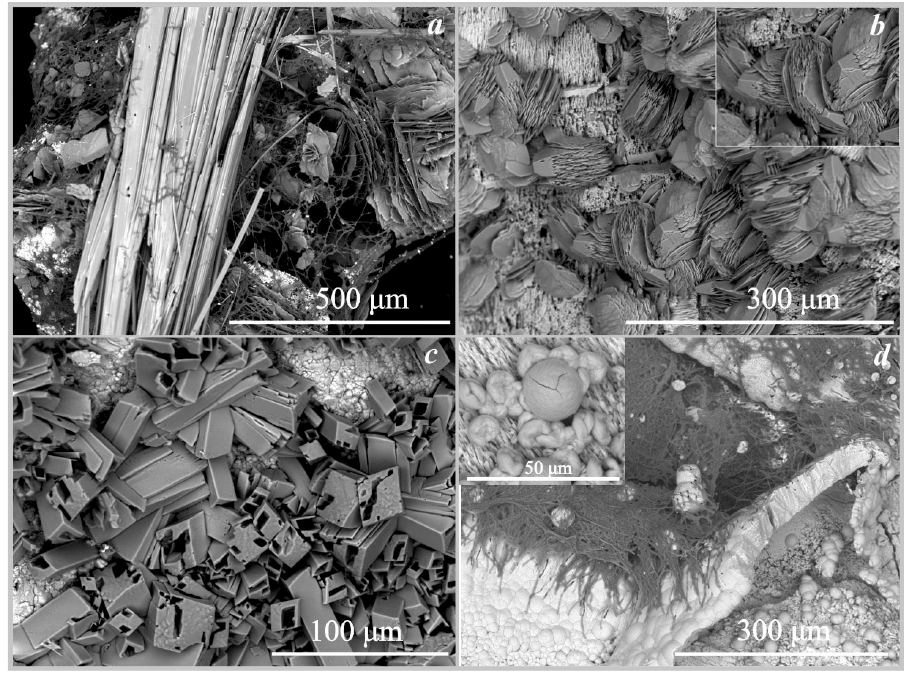
Figure 6. SEM images of the oxalate crystals formed under the action of Serpula himantioides : ( a )—falottaite and lindbergite on hollandite; ( b )—humboldtine on siderite; ( c )—humboldtine on pyrrhotite; ( d )—moolooite on synthetic malachite.